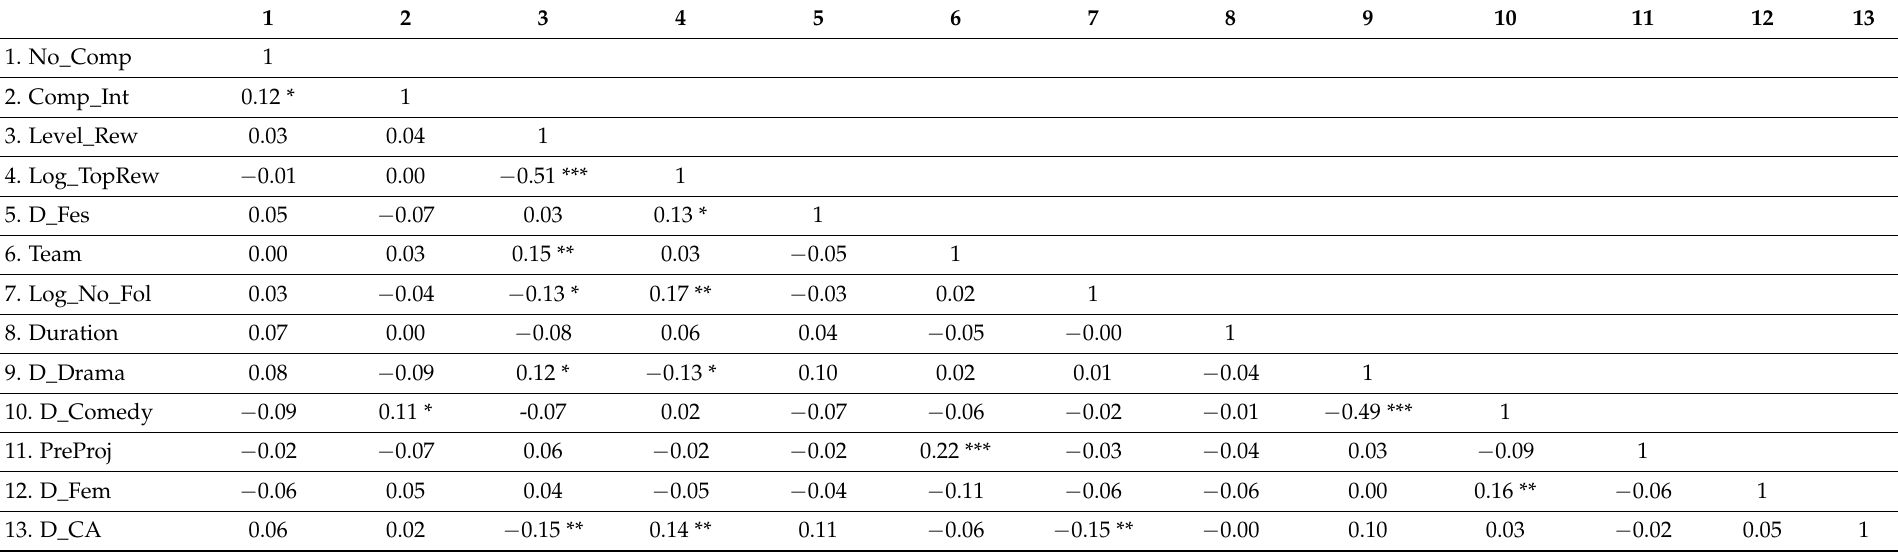
Table 2. Correlation matrix of